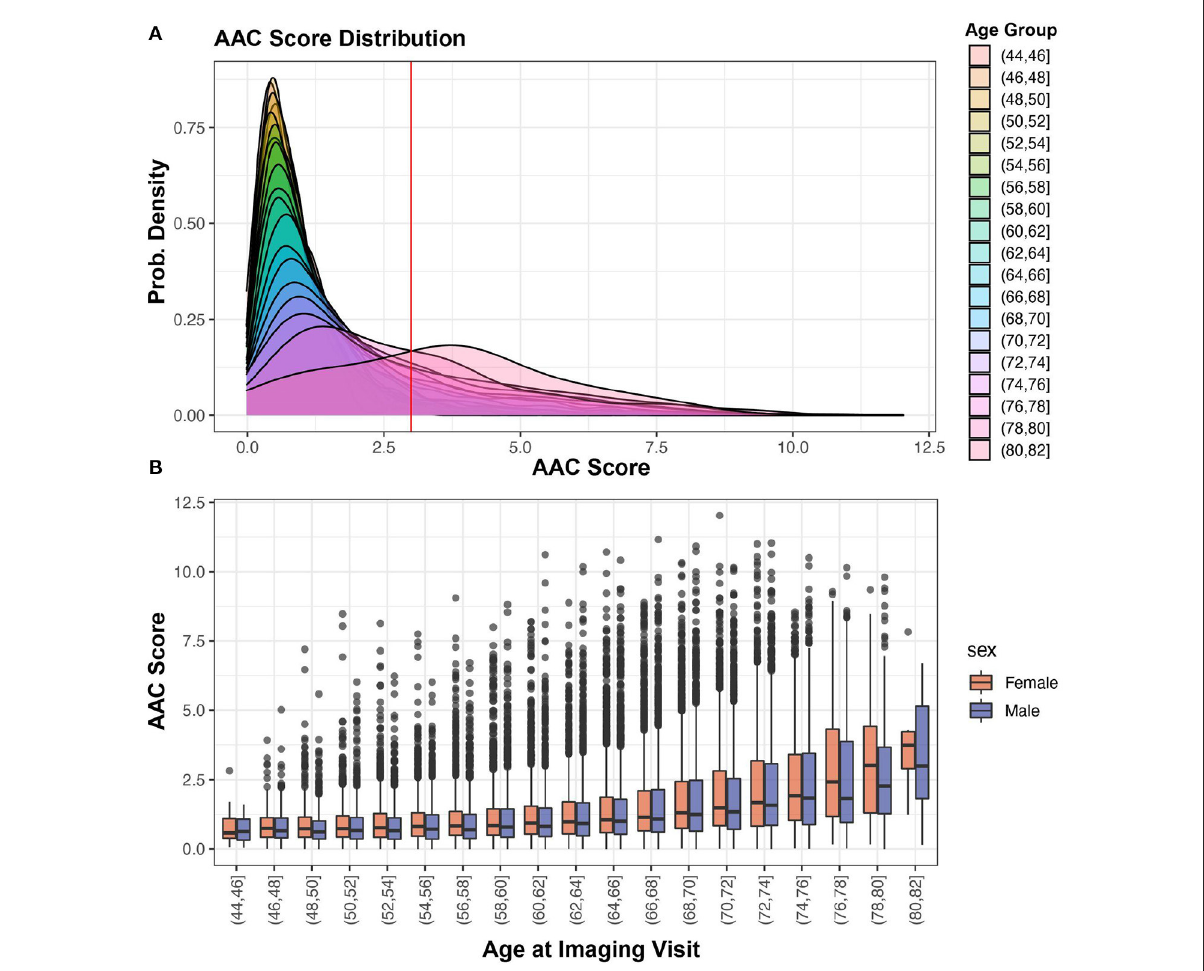
FIGURE4 AAC Prevalence. (A) Distribution of predicted AAC scores across 38,264 participants. The red line shows calcification score at mean plus one standard deviation (score ∼ 2.93). (B) Relationship between predicted AAC scores and age of the participants. There is a clear age-dependent increase in calcification in each age strata, with the median value, variance, and the number of extreme cases increasing across both sexes.